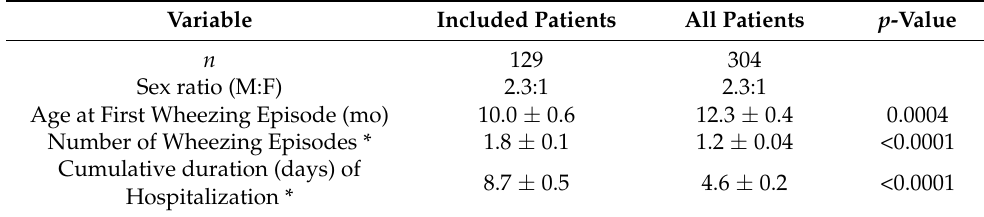
Table 2. Comparison of included patients vs. all wheezing/asthmatic